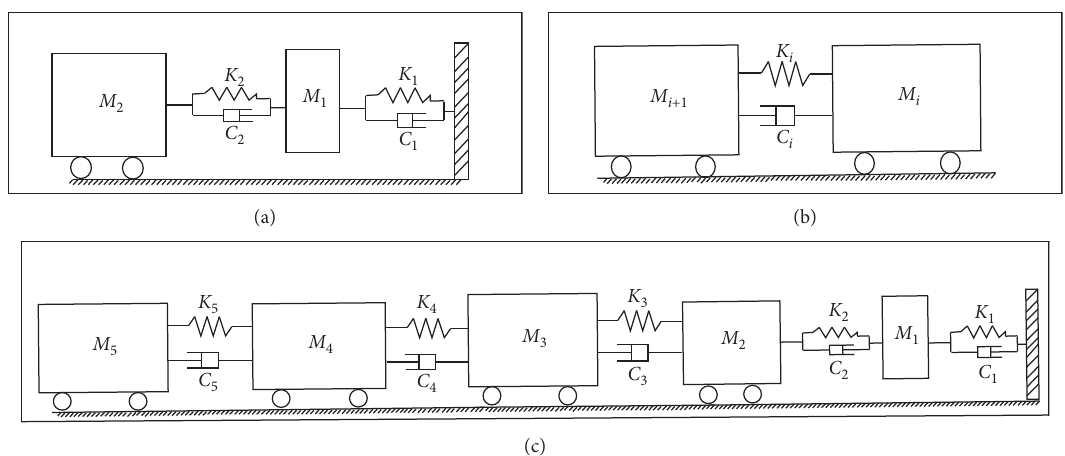
Figure 3: Nonlinear lumped model of (a) the head car, (b) intermediate vehicle, and (c)